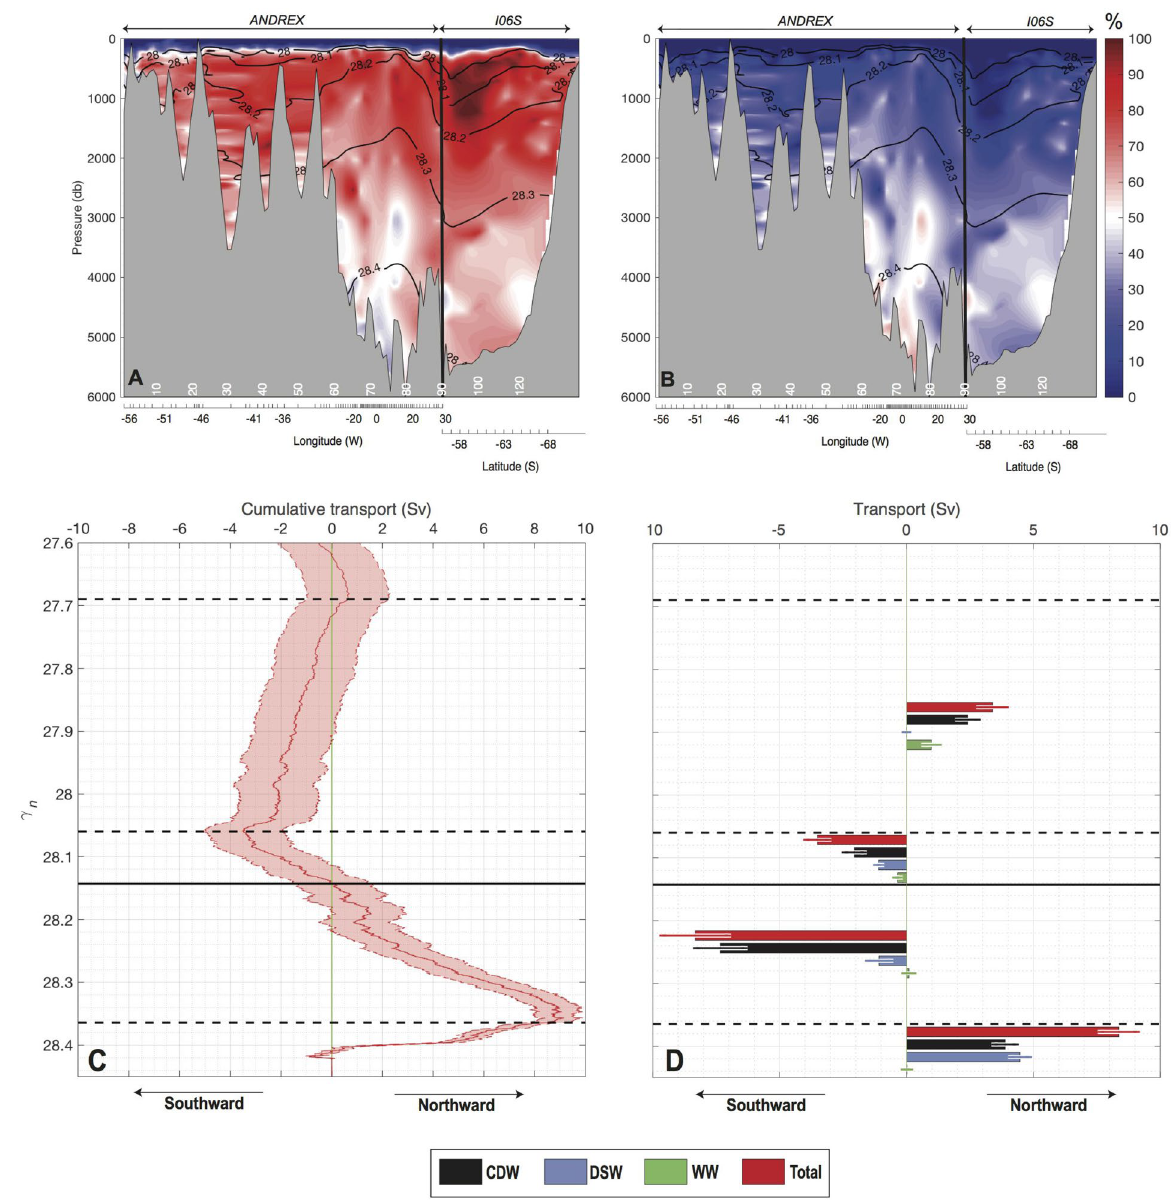
Figure 5. Percentage contributions of ( A ) CDW and ( B ) DSW across the ANDREX/I06S section (red stations in Fig. 1B). Black contours indicate neutral density isopycnals and x-axis is based on uneven linear longitude/ latitude axis corresponding to station numbers in white. ( C ) Total cumulative transport from the bottom ocean upward, summed across the ANDREX/I06S section, computed in neutral density coordinates. Shading indicates errors from a Monte-Carlo error estimate. Positive (negative) transport are directed out of (into) the gyre. ( D ) Net transports across the ANDREX/I06S into four density layers: 27.69–28.06 kg m − γ n ; 28.14–28.36 kg m − 3 γ n ; and denser than 28.36 kg m − 3 γ n . For each of these layers, the total net transport (red bars) are decomposed into their end-member contributions: (black) CDW, (blue) DSW, (green) WW. Positive (negative) transport are directed out of (into) the